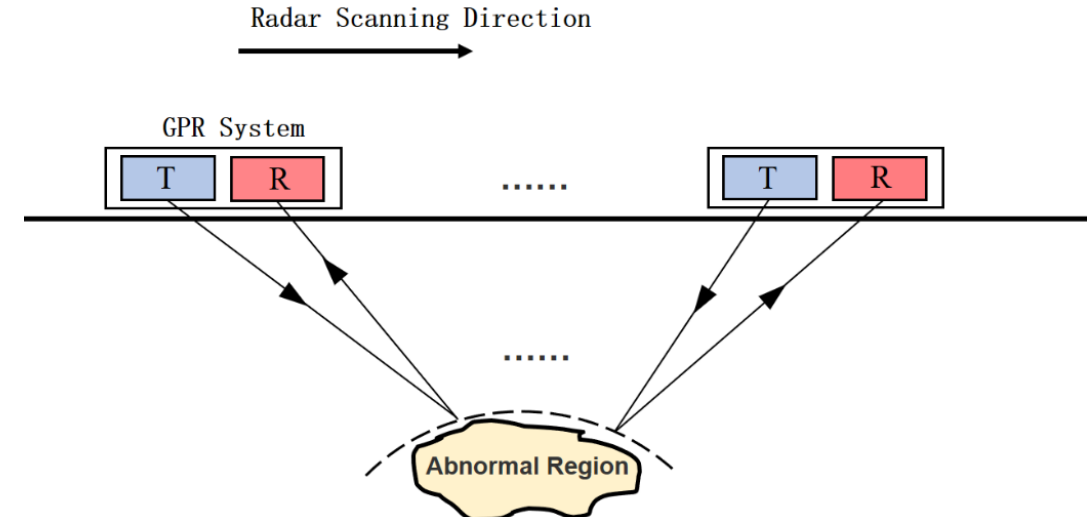
Figure 1. Continuous profile scanning survey of GPR.